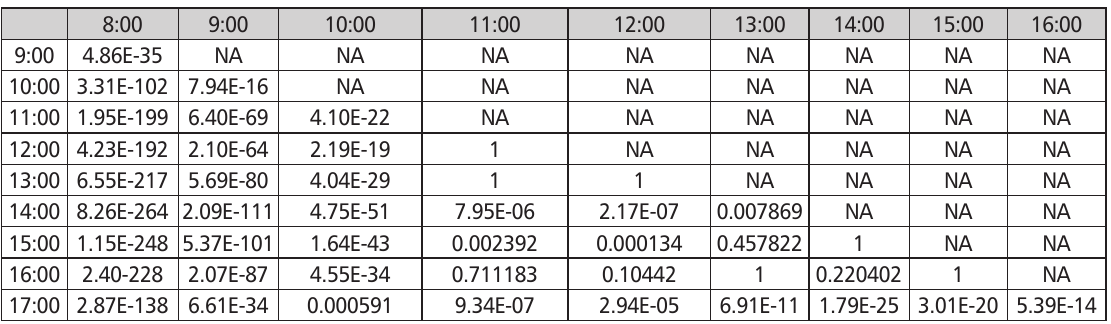
movements and conse-quently less temperature attenuation. On the other hand, Honey berry ( Meliccoca bijugatus ) and Malay almond ( Terminalia catappa ) trees have denser shadows and can generate more substantial thermic attenuations. Finally found that there are significant differences between the shadow temperature control (sun light direct) and any temperature under the surface shadow tree. This information suggests that tree physiology can play an important role in temperature attenuation in cities as a result of shadow effects and can be applied as a criterion to select urban trees in tropical